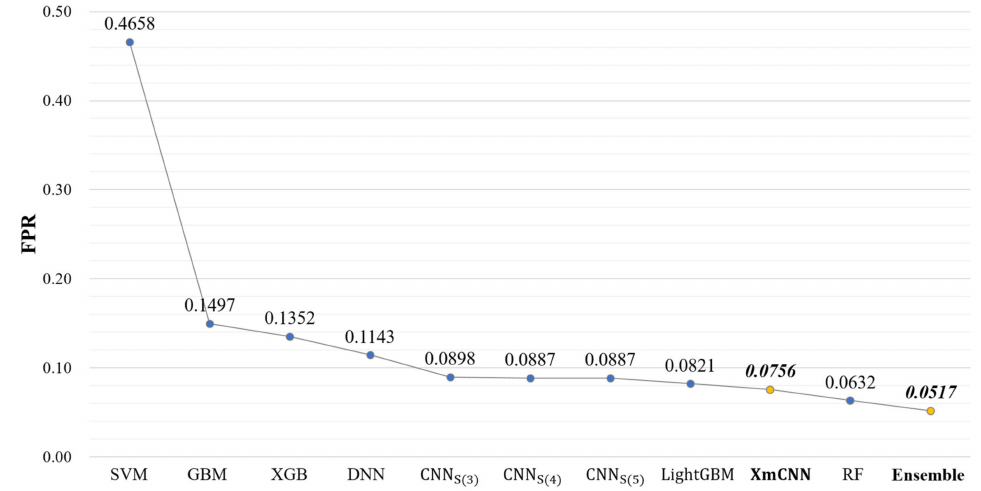
Figure 10. FPR comparison of the overall models. Ensemble indicates Ensemble ( CNN S ( 3 ) , CNN S ( 4 ) ,CNN S ( 5 ) , XmCNN )